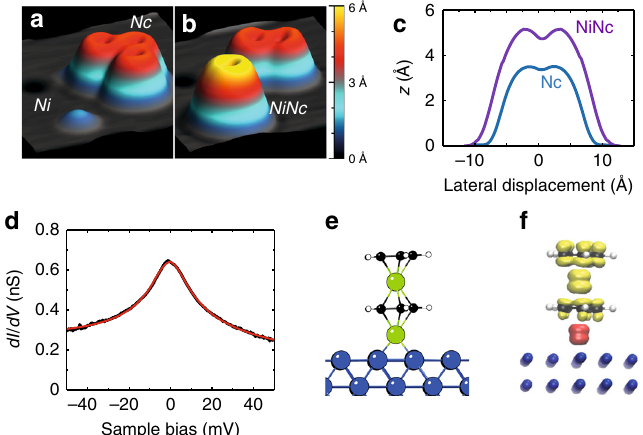
Fig. 4 Isolated NiNc on Cu(100). a , b Pseudo 3D images showing the tip-assisted assembly of an isolated NiNc complex (5 × 5 nm 2 , − 20 mV, 20 pA): a before and b after the transfer of Nc atop an isolated Ni adatom, and c height pro fi les of isolated NiNc and of isolated Nc. d d I /d V spectrum measured above the Cp ring of an isolated NiNc on Cu(100) (feedback loop opened at − 50 mV and 20 nA). The solid red line is a Frota-Fano fi t yielding a resonance centered at − 0.2 ± 0.2 meV and T K = 68 ± 7 K. e DFT optimized structure of isolated NiNc on Cu(100), and f Side view of the spin